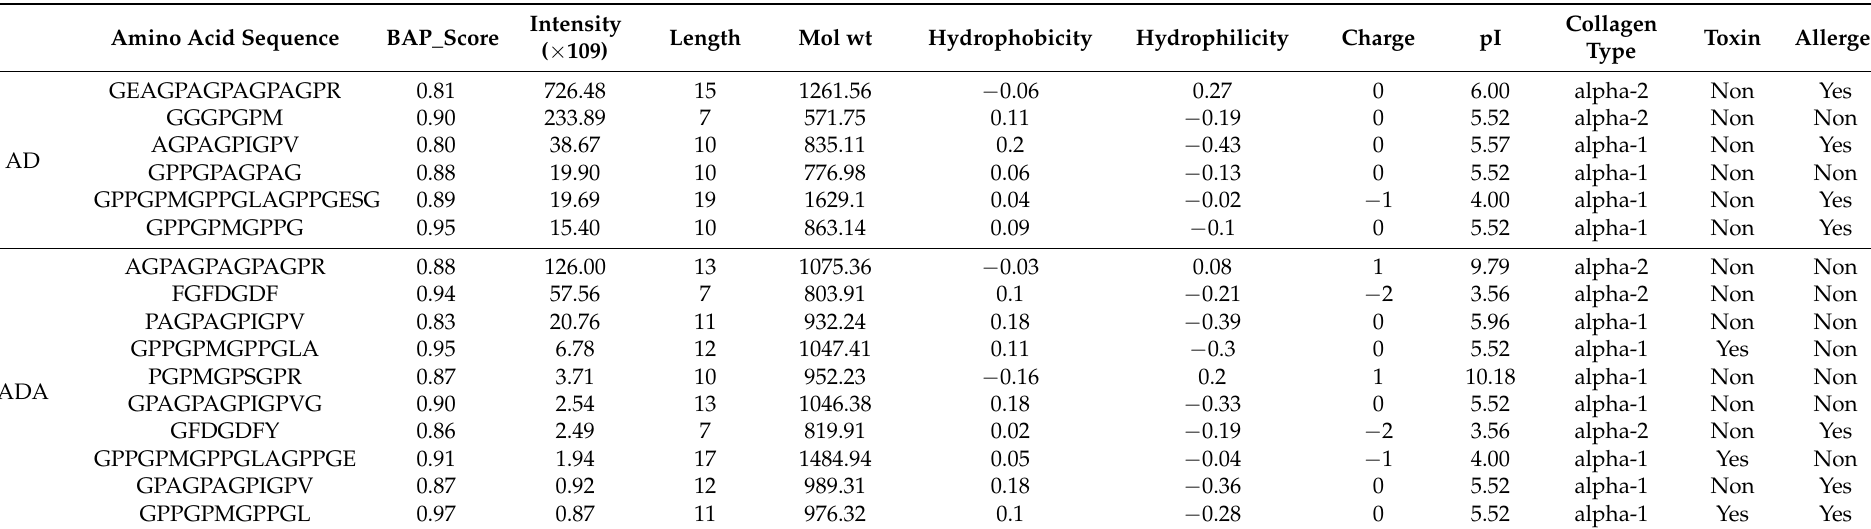
Table 1. The physicochemical properties and biological activity of anti-digestion and -absorption